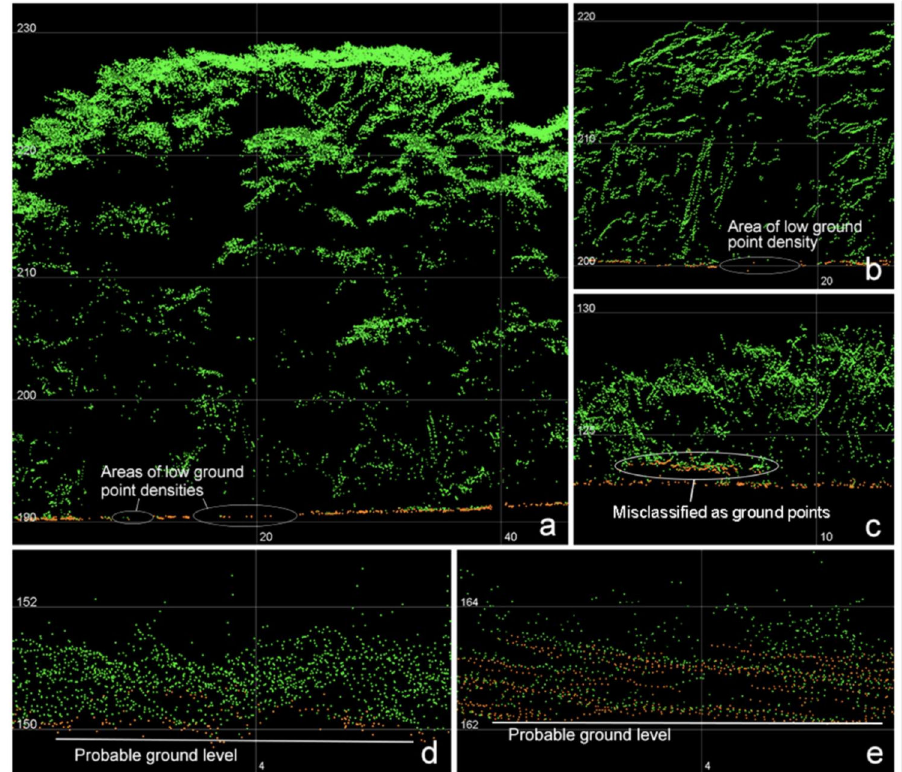
Figure 4. Point clouds from different vegetation types (( a ) primary forest; ( b ) high secondary forest; ( c ) medium height secondary forest; ( d ) low secondary forest; and ( e ) high grass) illustrating, in green, vegetation retrievals and, in orange, ground retrievals. Archaeological sites might be detected using the orange retrievals (figure reprinted with creative commons permission from